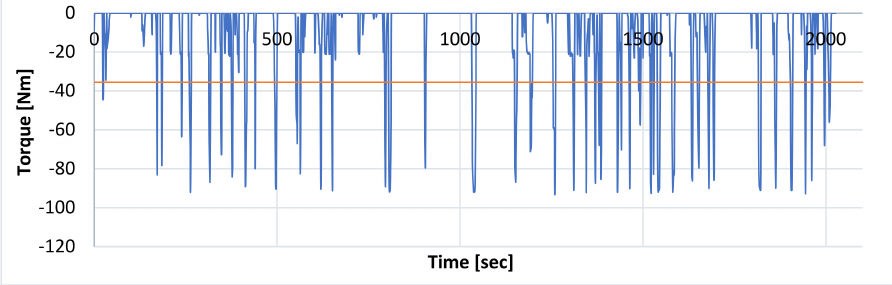
Figure 6. Variation in the total braking torque generated by electric motors with the average value marked for “eco”